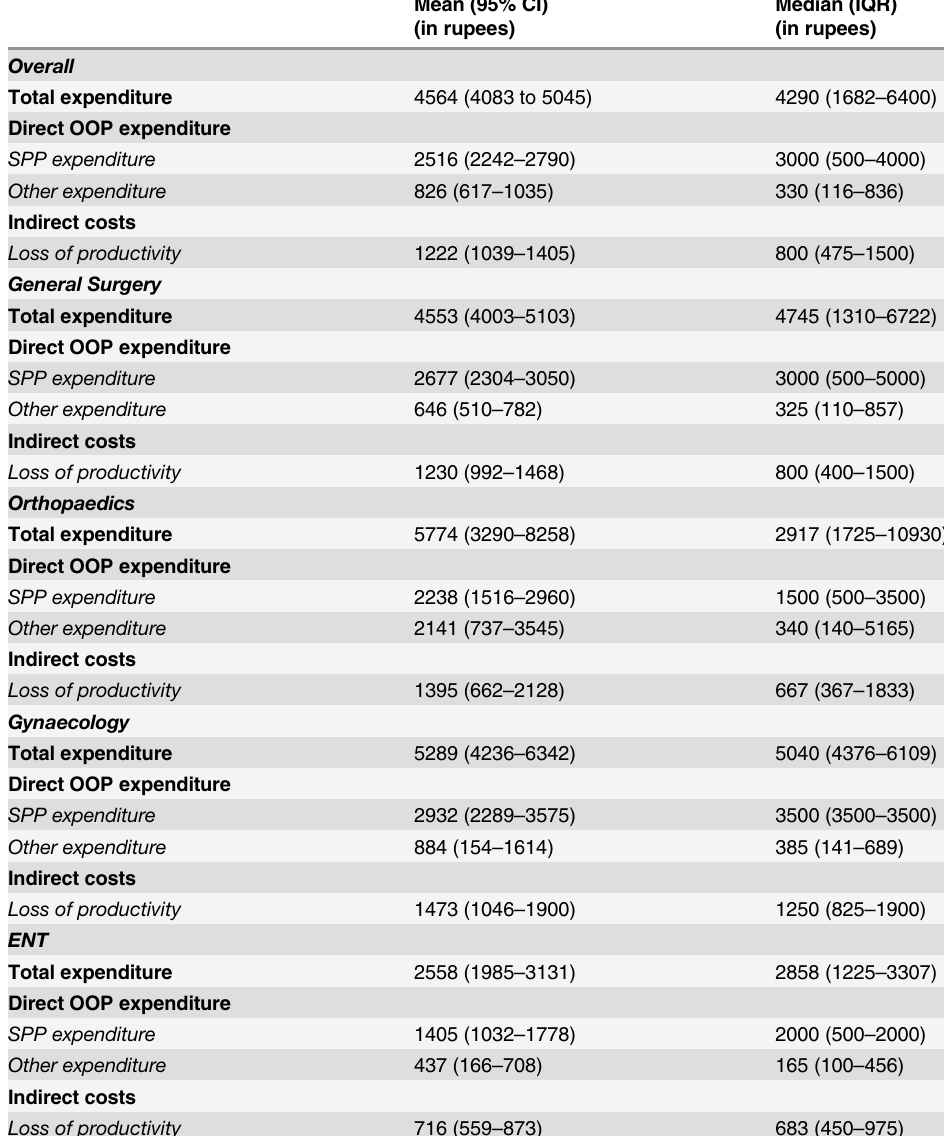
Table 4. Out-of-pocket expenditure incurred by the patients enrolled under Surgical Package Pro- gram (user charge program) in district Panchkula, Haryana. Mean (95%